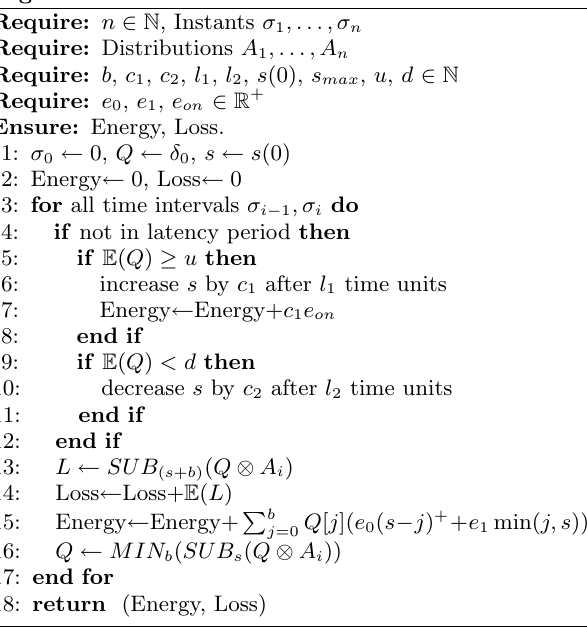
Algorithm 2 Tool’s main function